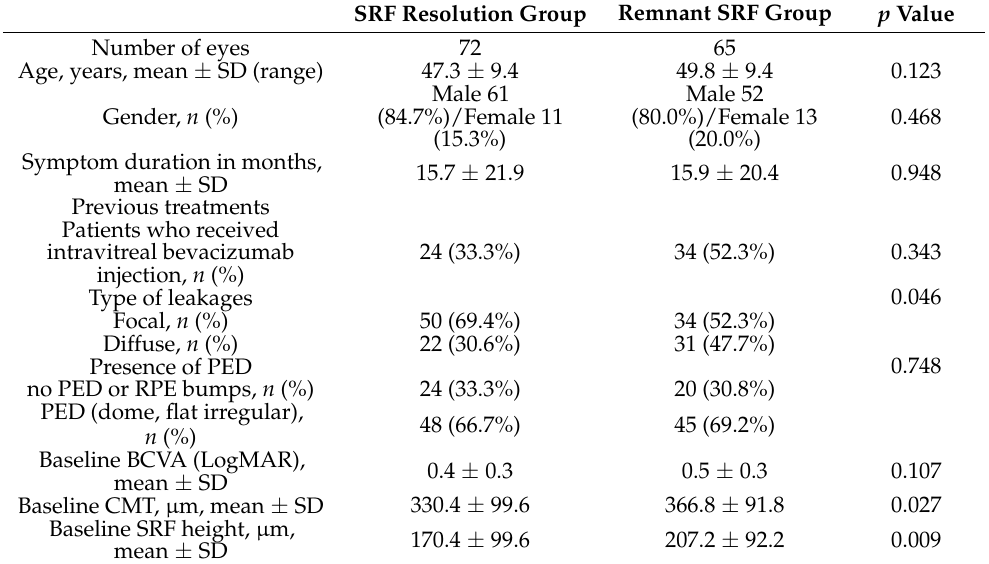
Table 4. The type of leakage ( p = 0.046), mean CMT ( p = 0.027), and SRF height ( p = 0.009) differed significantly between the groups. Table 4. Comparison of baseline characteristics between complete SRF resolution and remnant SRF groups 3 months after selective retina